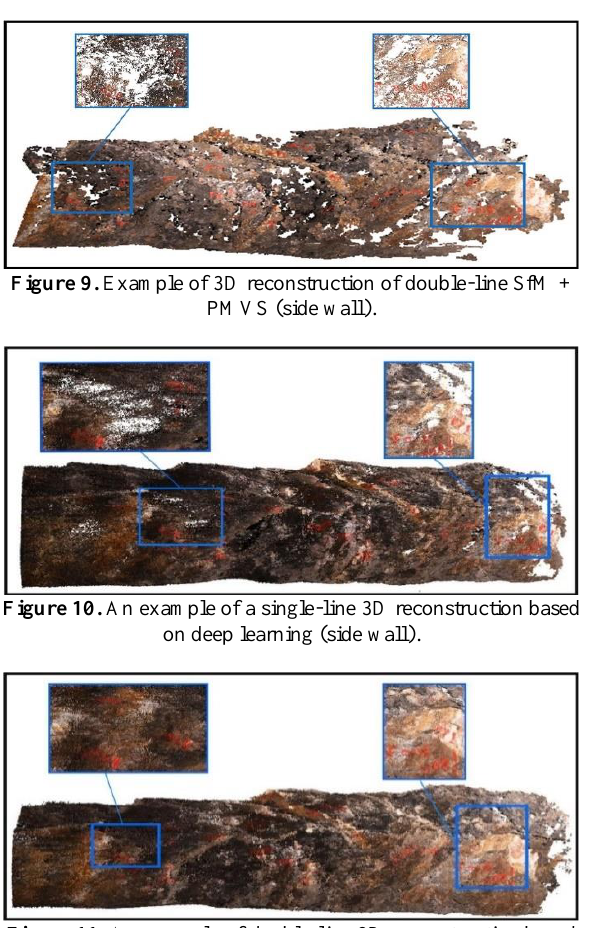
Figure 8. Example of 3D reconstruction of single-line SfM + PMVS (side wall).